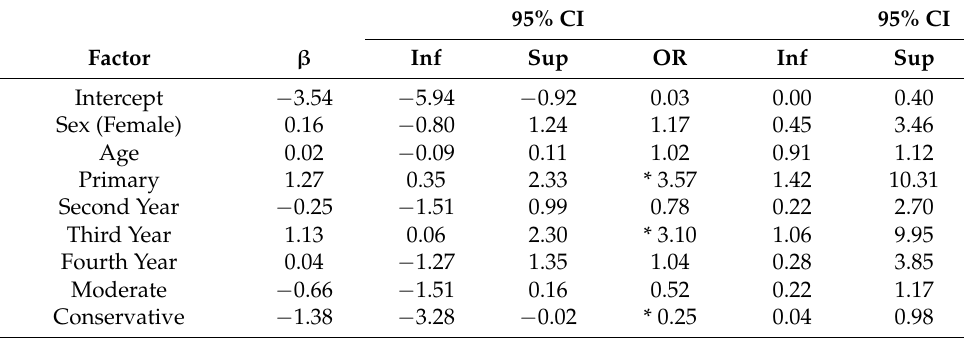
Table 4. Logistic regression